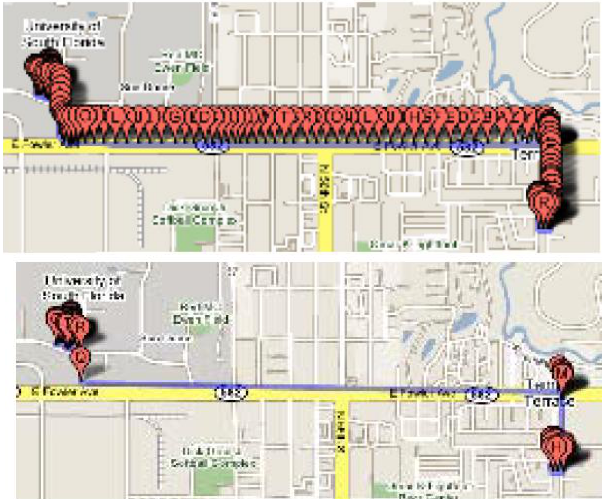
Figure 6 . Comparison between Car trip data with All GPS Points (top) and Car trip data with only Critical Points (below) [13].